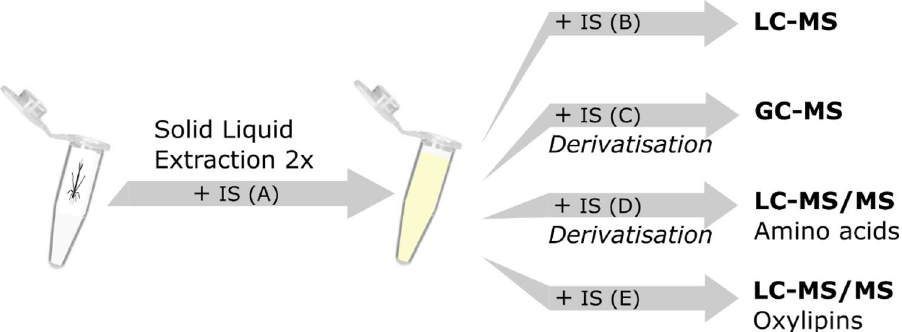
Figure 2. Extraction and metabolite analysis scheme. Internal standard (IS) mix A was added during solid liquid extraction and contained one IS for LC–MS, GC–MS, and amino acid analyses, respectively, as well as 9 IS for oxylipin analysis. IS mix B, C, D, E were added after extraction/before respective analyses (see Table S6 in Supplementary